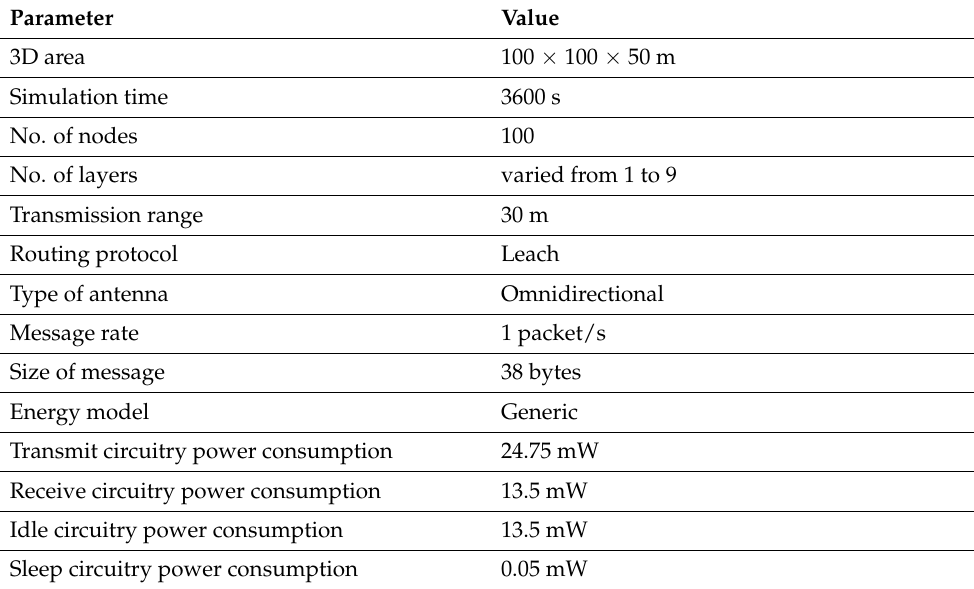
Table 1. Simulation parameters used for the analysis of wireless sensor networks.